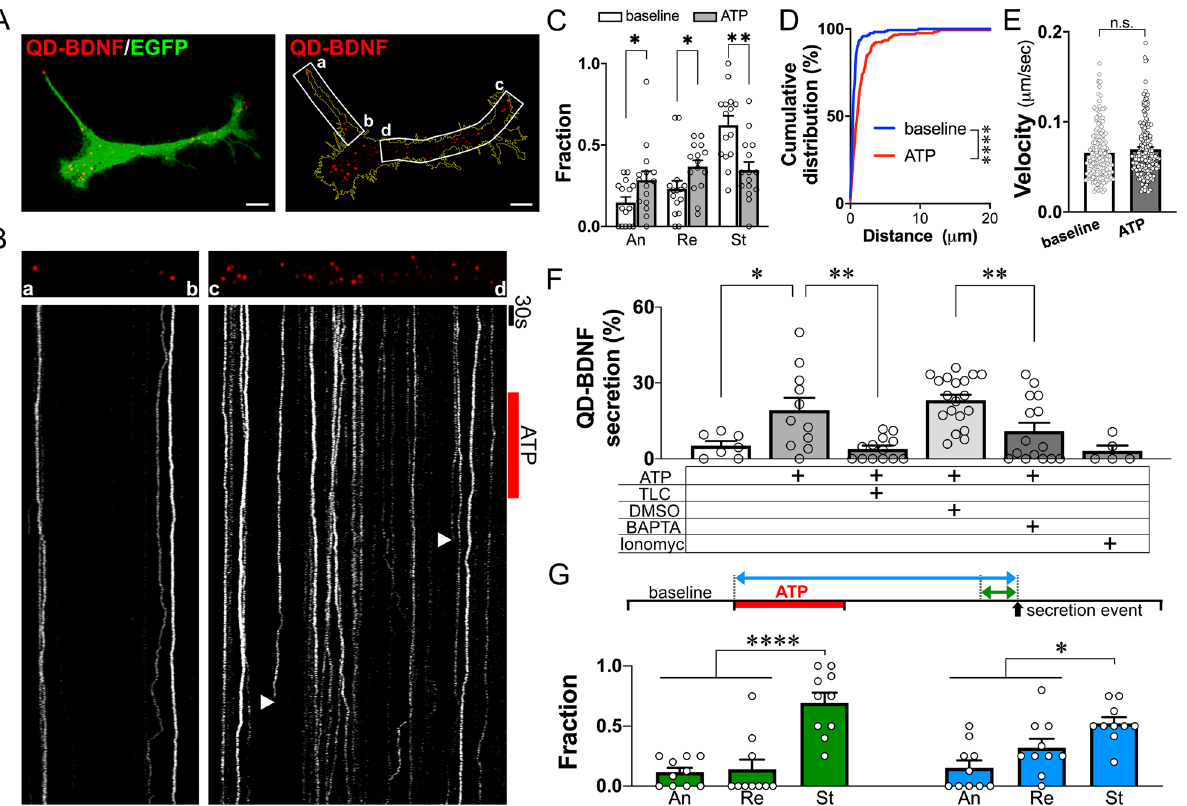
Figure 2. ATP stimulation results in the Ca 2+ -dependent exocytosis of endocytic BDNF. (A) Left: Representative fluorescence image of EGFP-expressing astrocytes containing QD-BDNF. Right: QD fluorescence image of the cell in ( A) . Yellow line: cell boundary determined by EGFP signals. White boxes: linearized segments used to generate the kymographs in ( B ) Scale bar = 10 µm. ( B) Representative kymographs indicated in ( A) generated by using ImageJ/FIJI software (Ver. 2.1.0/1.53c, NIH). Red bar: ATP (100 µM) treatment. Arrow heads: disappearances of QD-BDNF fluorescence. ( C) Average QD-BDNF fractions showing immobility (St) or anterograde (An)/retrograde (Re) transport. * P < 0.05, ** P < 0.01. ( D) Cumulative distributions of the QD-BDNF transport distances at baseline and after ATP stimulation (ATP). **** P < 0.0001. ( E) Average velocities of mobile QD-BDNF particles. n.s., not significantly different. N = 173 particles from 14 cells for each group. ( F) Average percentages of secreted QD-BDNF. TLC: tetanus toxin light chain. Ionomyc: ionomycin (1 µM). * P < 0.05, ** P < 0.01. N = 5–11 cells for each group. ( G) Average secreted QD-BDNF fractions showing immobility or An/Re transport before exocytosis. Green: 60 s before exocytosis. Blue: immediately prior to ATP treatment. * P < 0.05, **** P < endocytic BDNF-containing vesicles, but modification of vesicle trafficking or sorting by P2 receptor-mediated Ca 2+ or lipid signaling 26–28 may be implicated. Our work also uncovered the complex molecular nature underlying endocytic BDNF secretion from astro- cytes. We discovered that chelation of ATP-induced Ca 2+ elevation partially reduces QD-BDNF exocytosis, whereas a direct increase in intracellular Ca 2+ concentration cannot evoke QD-BDNF exocytosis (Fig. 2F). These findings imply the requirement of additional signaling pathway for full exocytosis of endocytic BDNF. For example, modification of cAMP concentration through P2 receptor activation 30,31 or A2 receptors 32 , may influ- ence endocytic BDNF release by activating cAMP-dependent signaling pathways important for vesicle docking or exocytosis 29,33 . Moreover, Vamp3-independent mechanisms may also be implicated in regulating endocytic